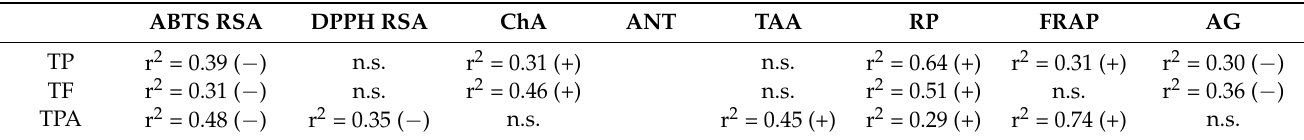
Table 8. Coefficients of determination for significant ( p < 0) correlations between the content of phenolic compounds (TP, TF, and TPA) and antioxidant